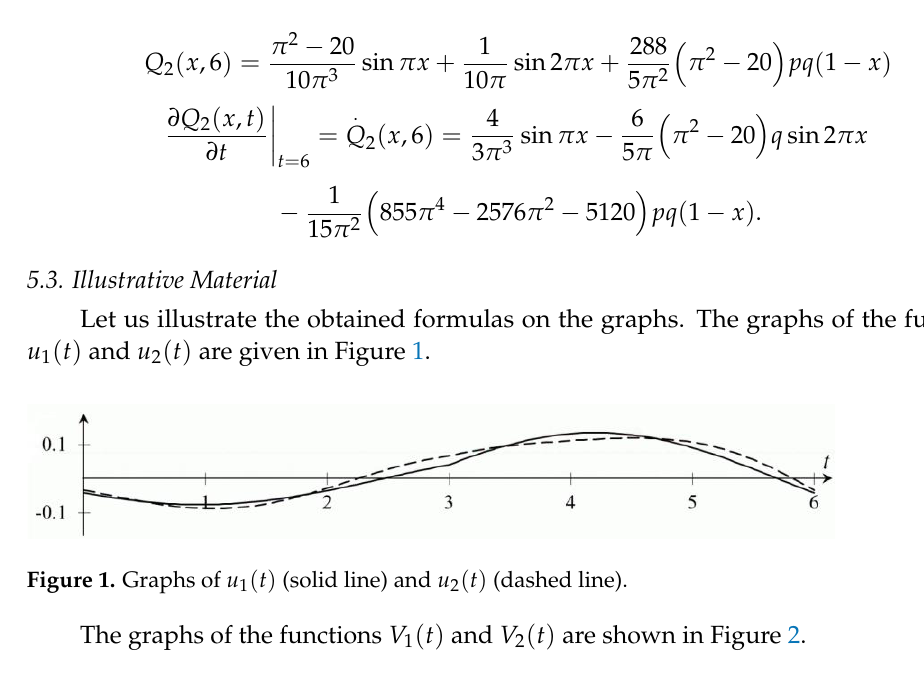
Figure 5. Graphs of 𝑄 1 (𝑥, 6) (solid line) and 𝑄 2 (𝑥, 6) (dashed line).